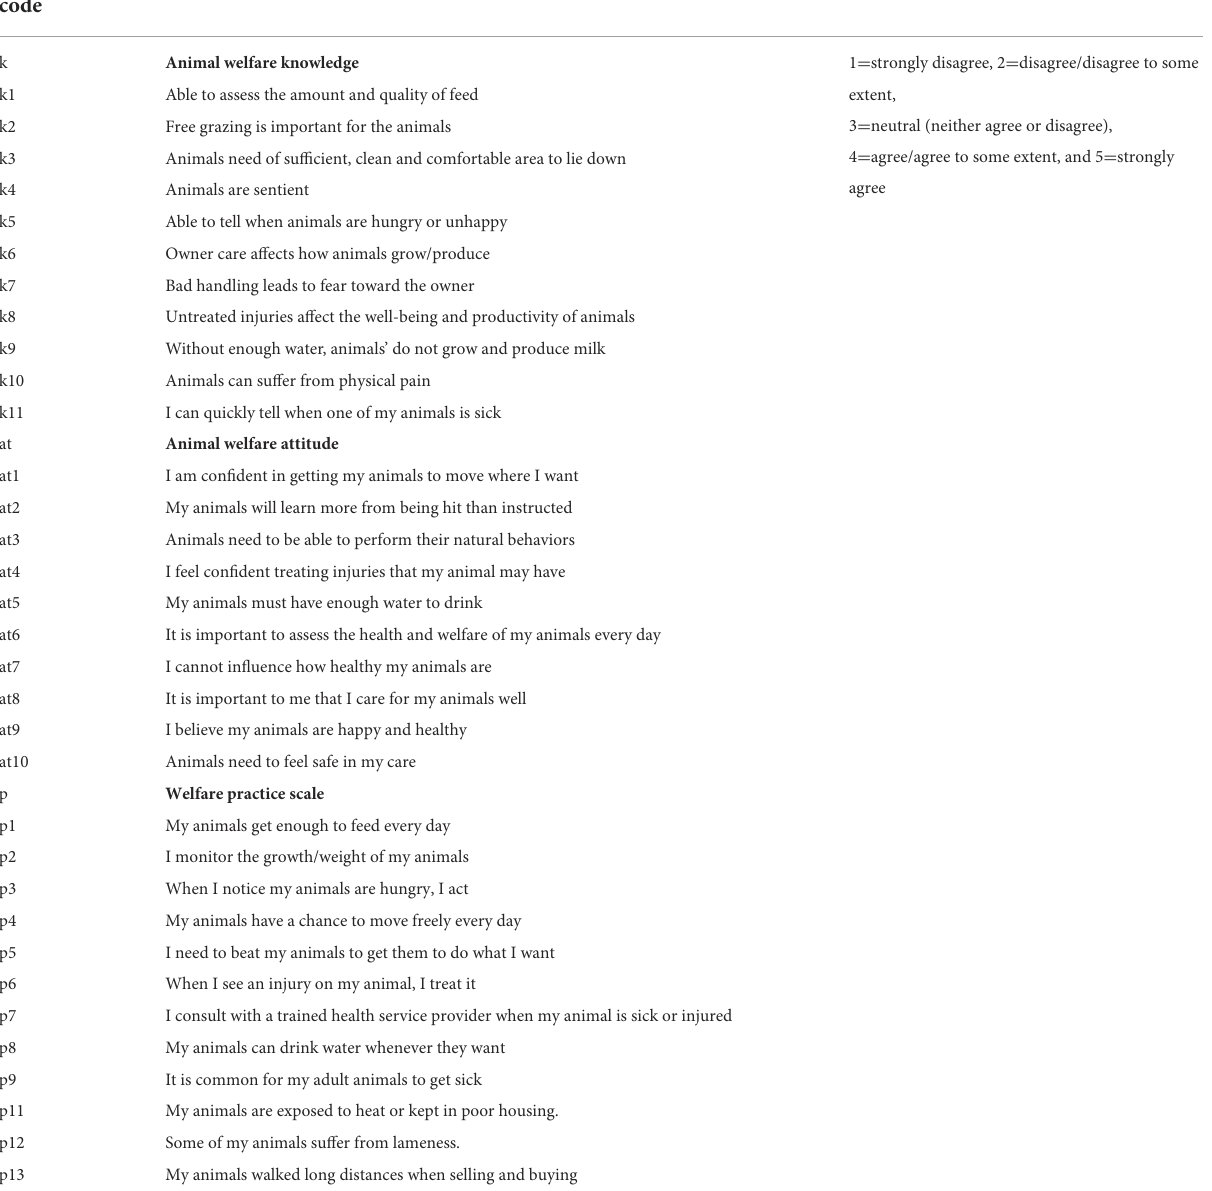
TABLE 1 Description of items used to assess the knowledge, attitude, and practice among livestock